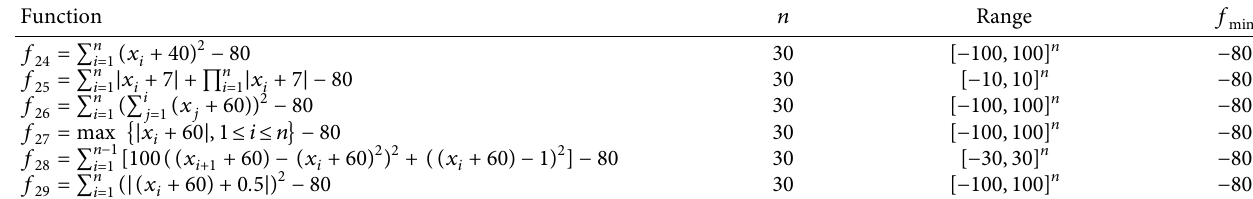
Table 4: Shifted and biased unimodal benchmark functions.